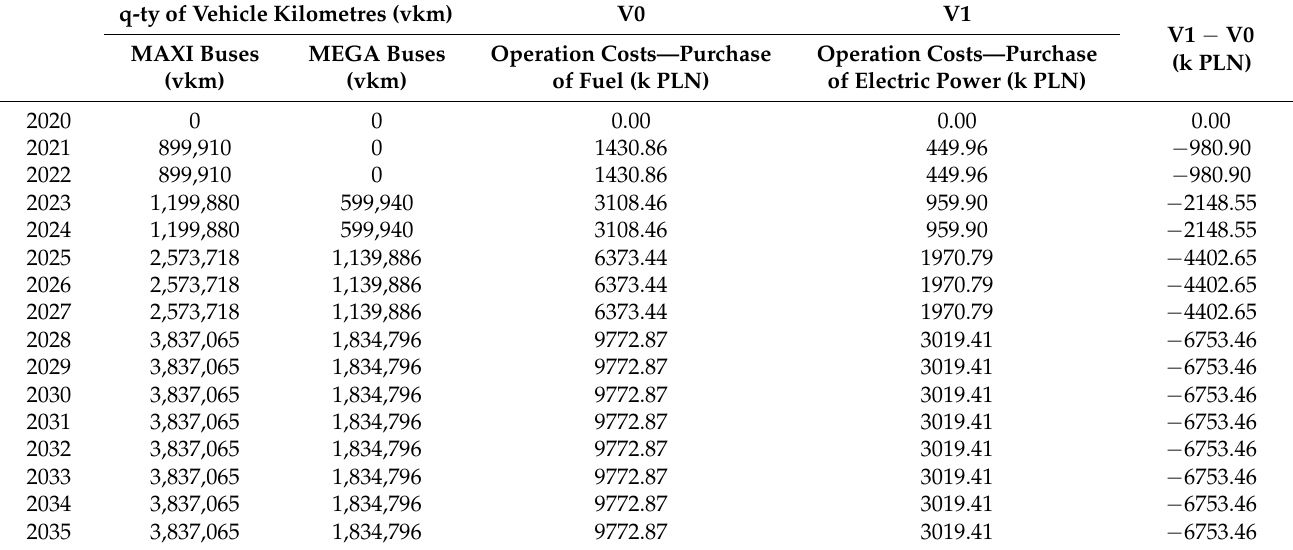
Table 4. Comparing the vehicle operation costs for variants V0 and